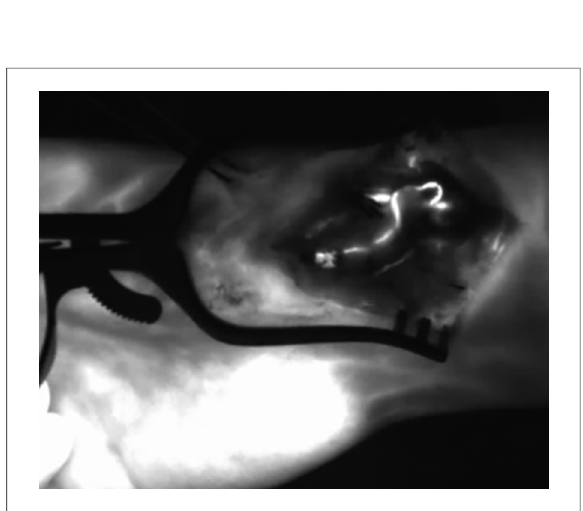
FIGURE 5 After end-to-side anastomosis of the pedicle artery to the radial artery and ICG dye application. The ICG angiography signal indicates patency of the arterial vascular pedicle of the bone graft; ICG, indocyanine green; NIR,